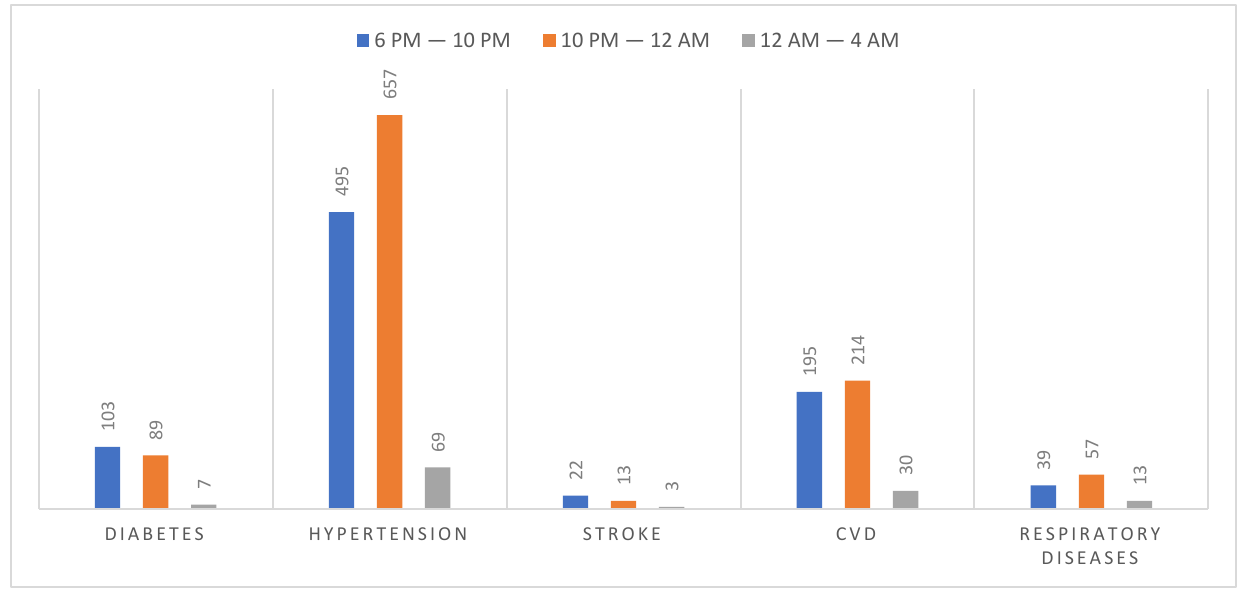
Figure 1. Bedtime in participants with chosen noncommunicable diseases. In the case of every disease, there were statistically significant differences between the categories differentiated by bedtime ( p < 0.02). CVD—cardiovascular diseases.